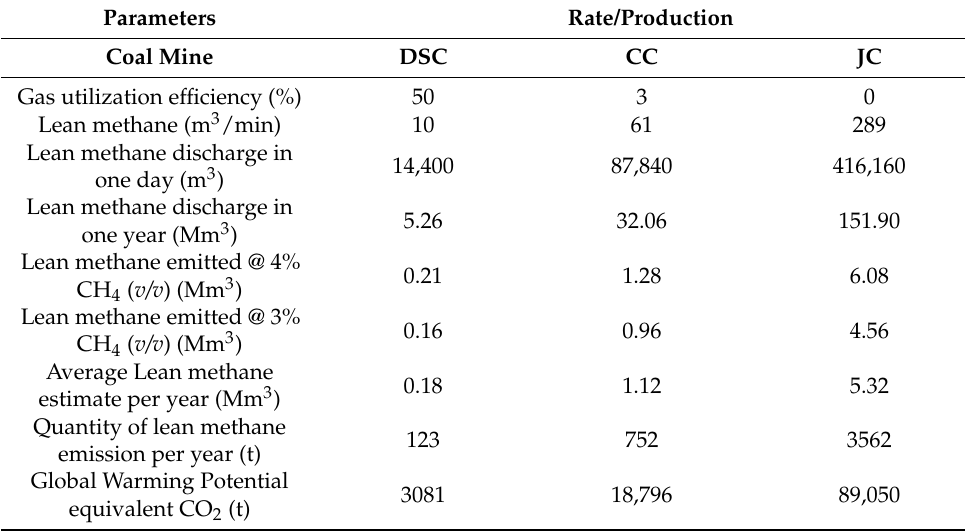
Table 2. Lean methane emissions estimation for coal mines in three